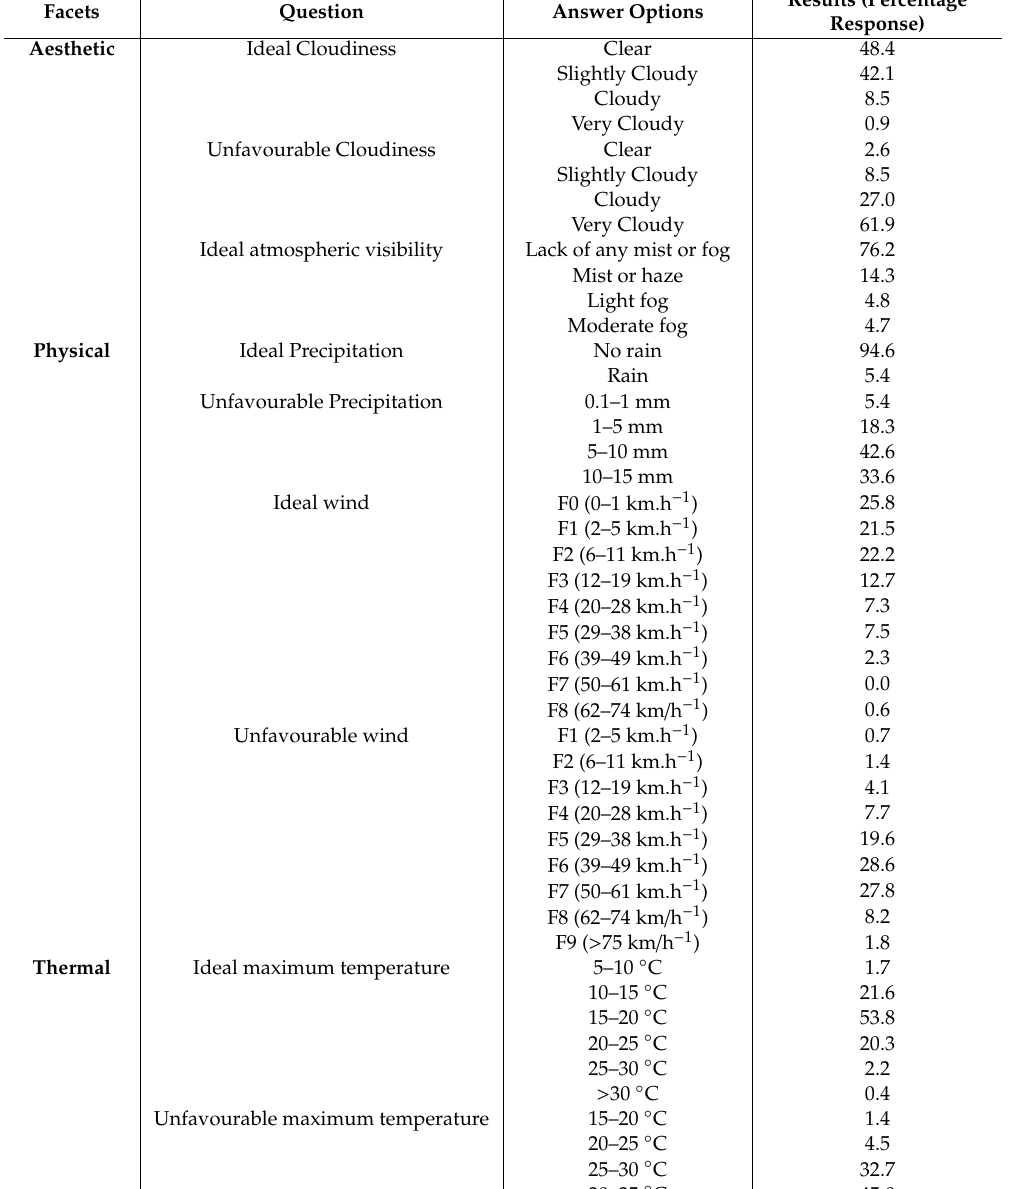
Table 2. Synthesis of the results by climatic